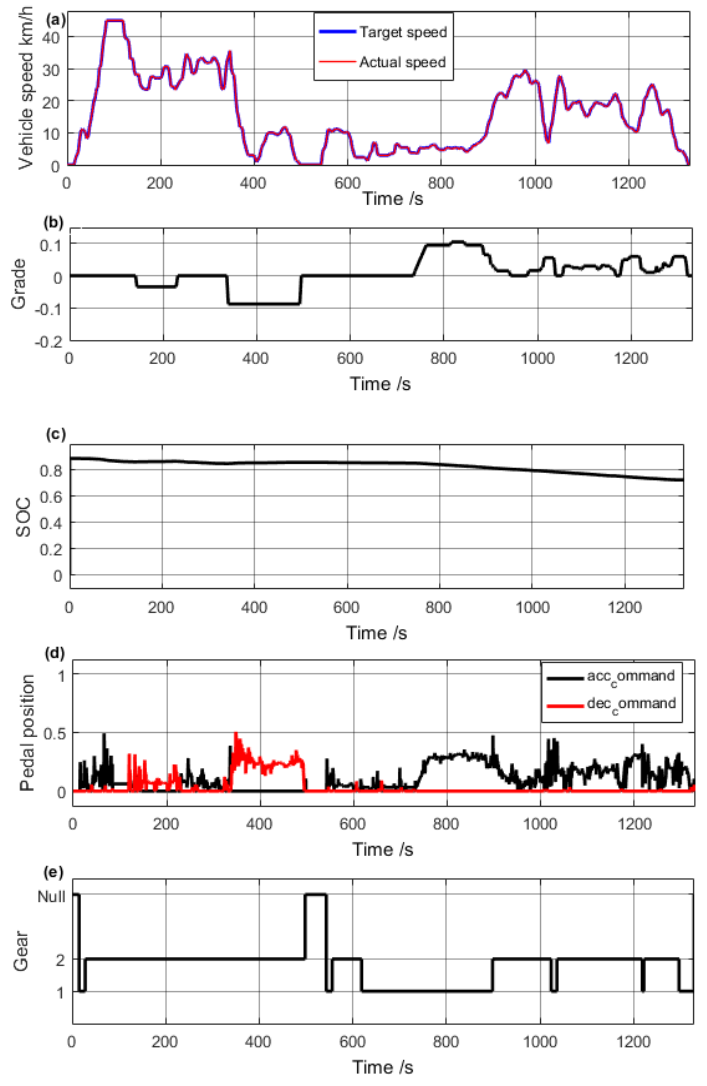
Figure 14. Simulation results: ( a ) velocity comparison; ( b ) road grade; ( c ) SOC curve; ( d ) pedal position of acceleration and brake; and ( e ) gear control sequence.